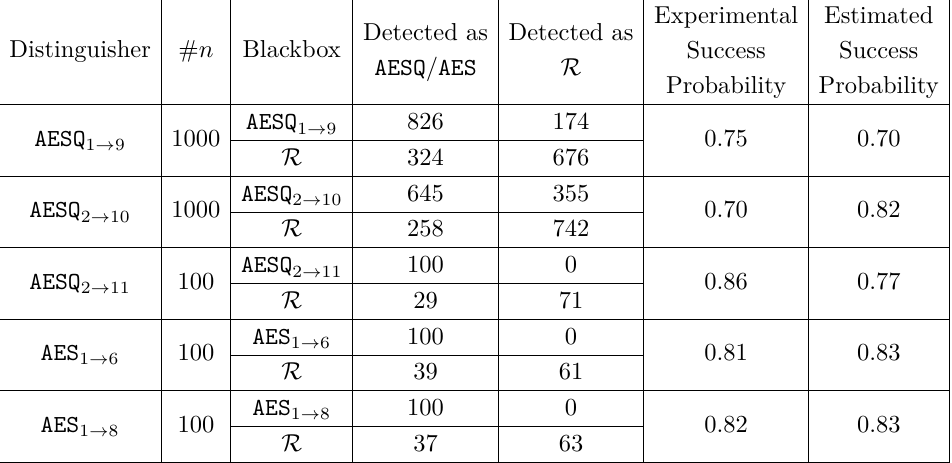
Table 6: Experimental Verification of Success